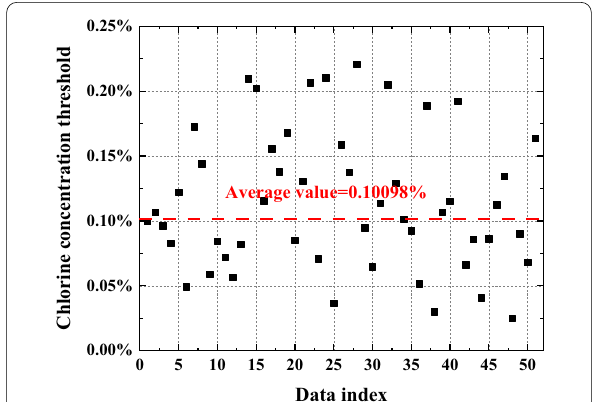
Fig. 2 Statistics of critical chloride ion